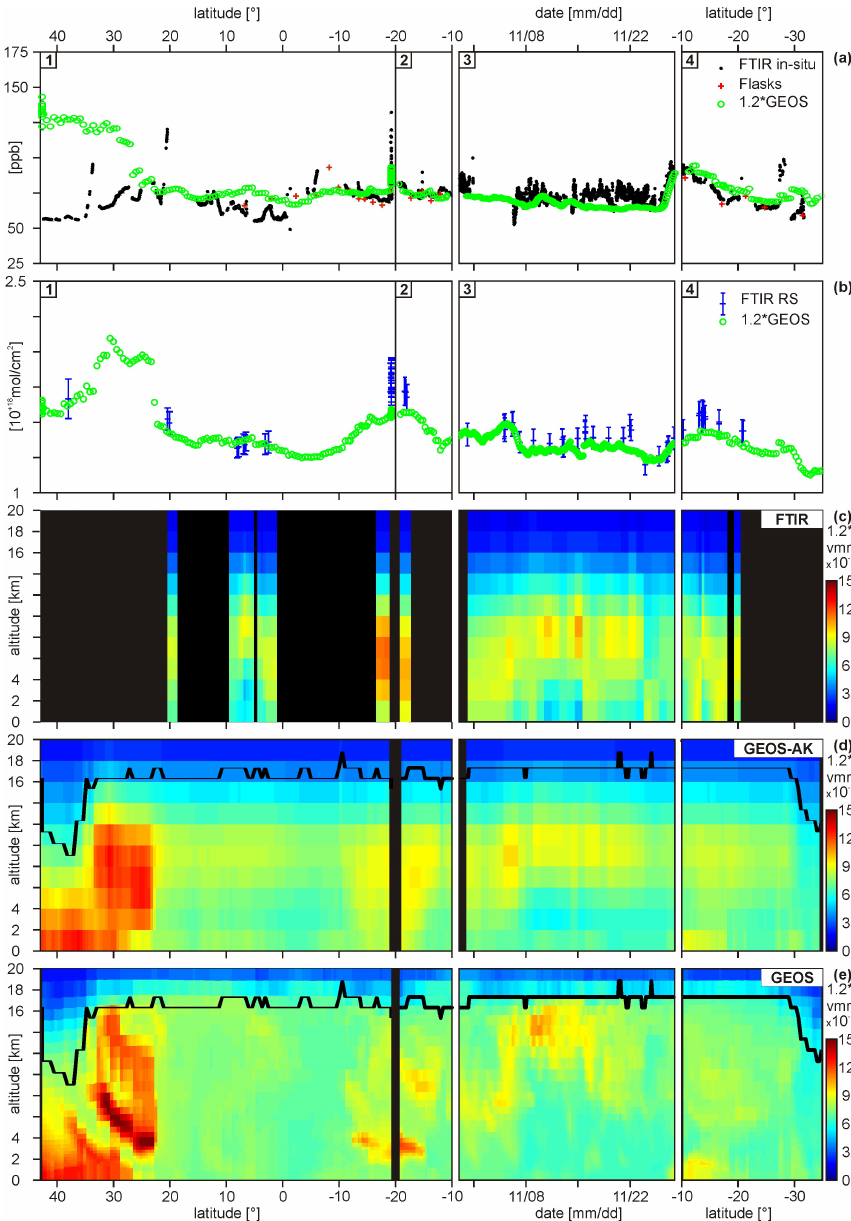
Fig. 4. CO distribution during the four sections of the ship campaign with RV Sonne in the Western Pacific; (a) surface volume mixing ratios obtained from FTIR in-situ measurements (black dots) and flask sampling (red crosses) compared to the GEOS-Chem model (green circles), (b) total column concentrations obtained from solar absorption FTIR measurements (blue markers, the error bars represent the theoretical uncertainty in the FTIR retrieval) compared to the GEOS-Chem model (green circles), (c) solar absorption FTIR profiles, (d) GEOS-Chem profiles smoothed with FTIR averaging kernels, (e) raw GEOS-Chem profiles. The black lines in (d) and (e) represent the model tropopause